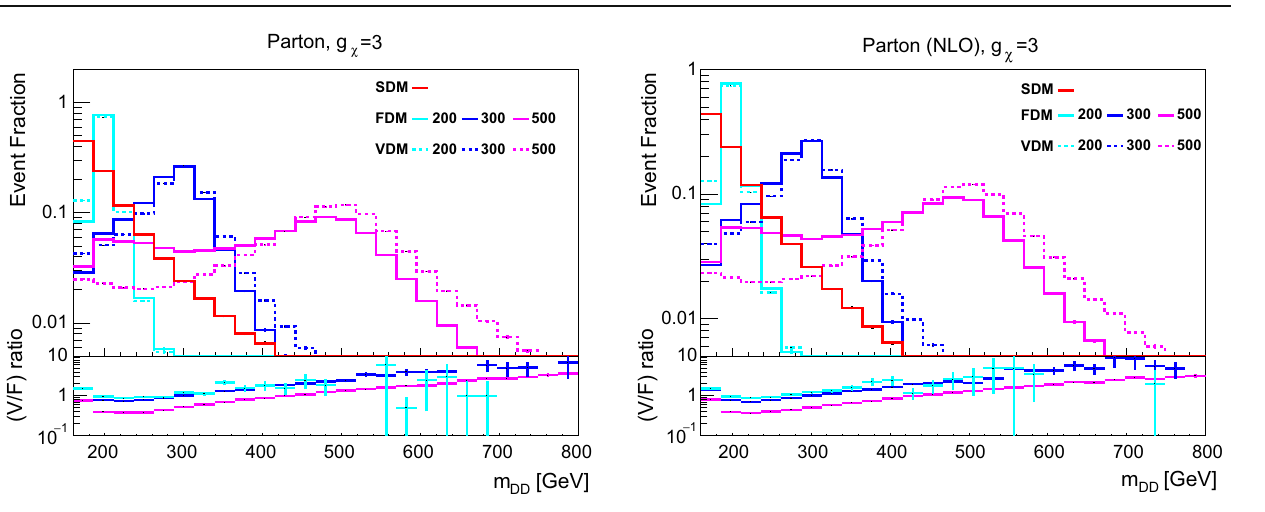
benchmark points in VDM model which have the same H 2 masses with the points in FDM model that are shown by the solid lines with the same colors. All distributions are normalized to